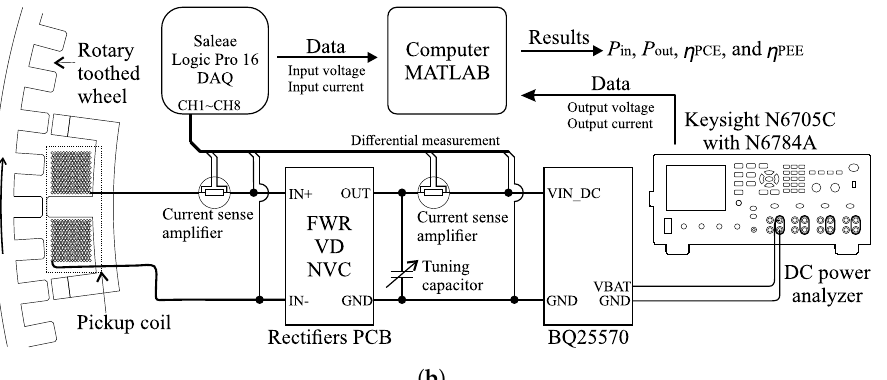
Figure 9. Overview of the experimental setup with the rotating shaft, the VREH transducer, the interface circuit implementations, a reference encoder, and data acquisition instruments in view of